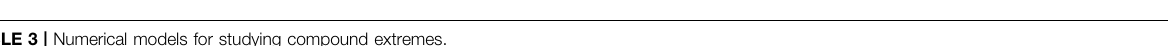
TABLE 3 | Numerical models for studying compound